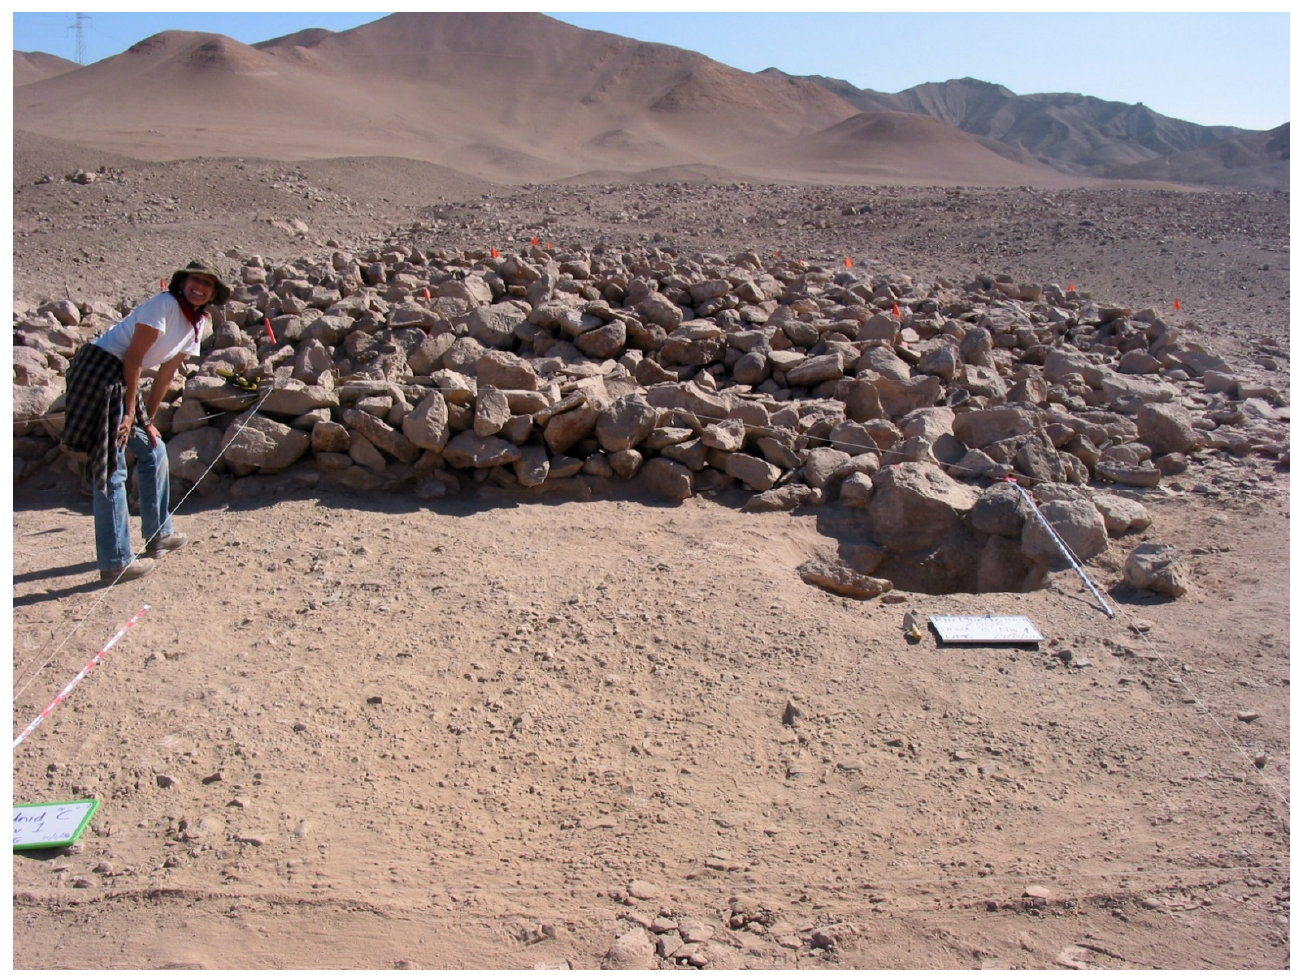
Figure 2. Rockpile cemetery feature at Rio Muerto, M70B prior to excavation (photo by Paul S. Gold-